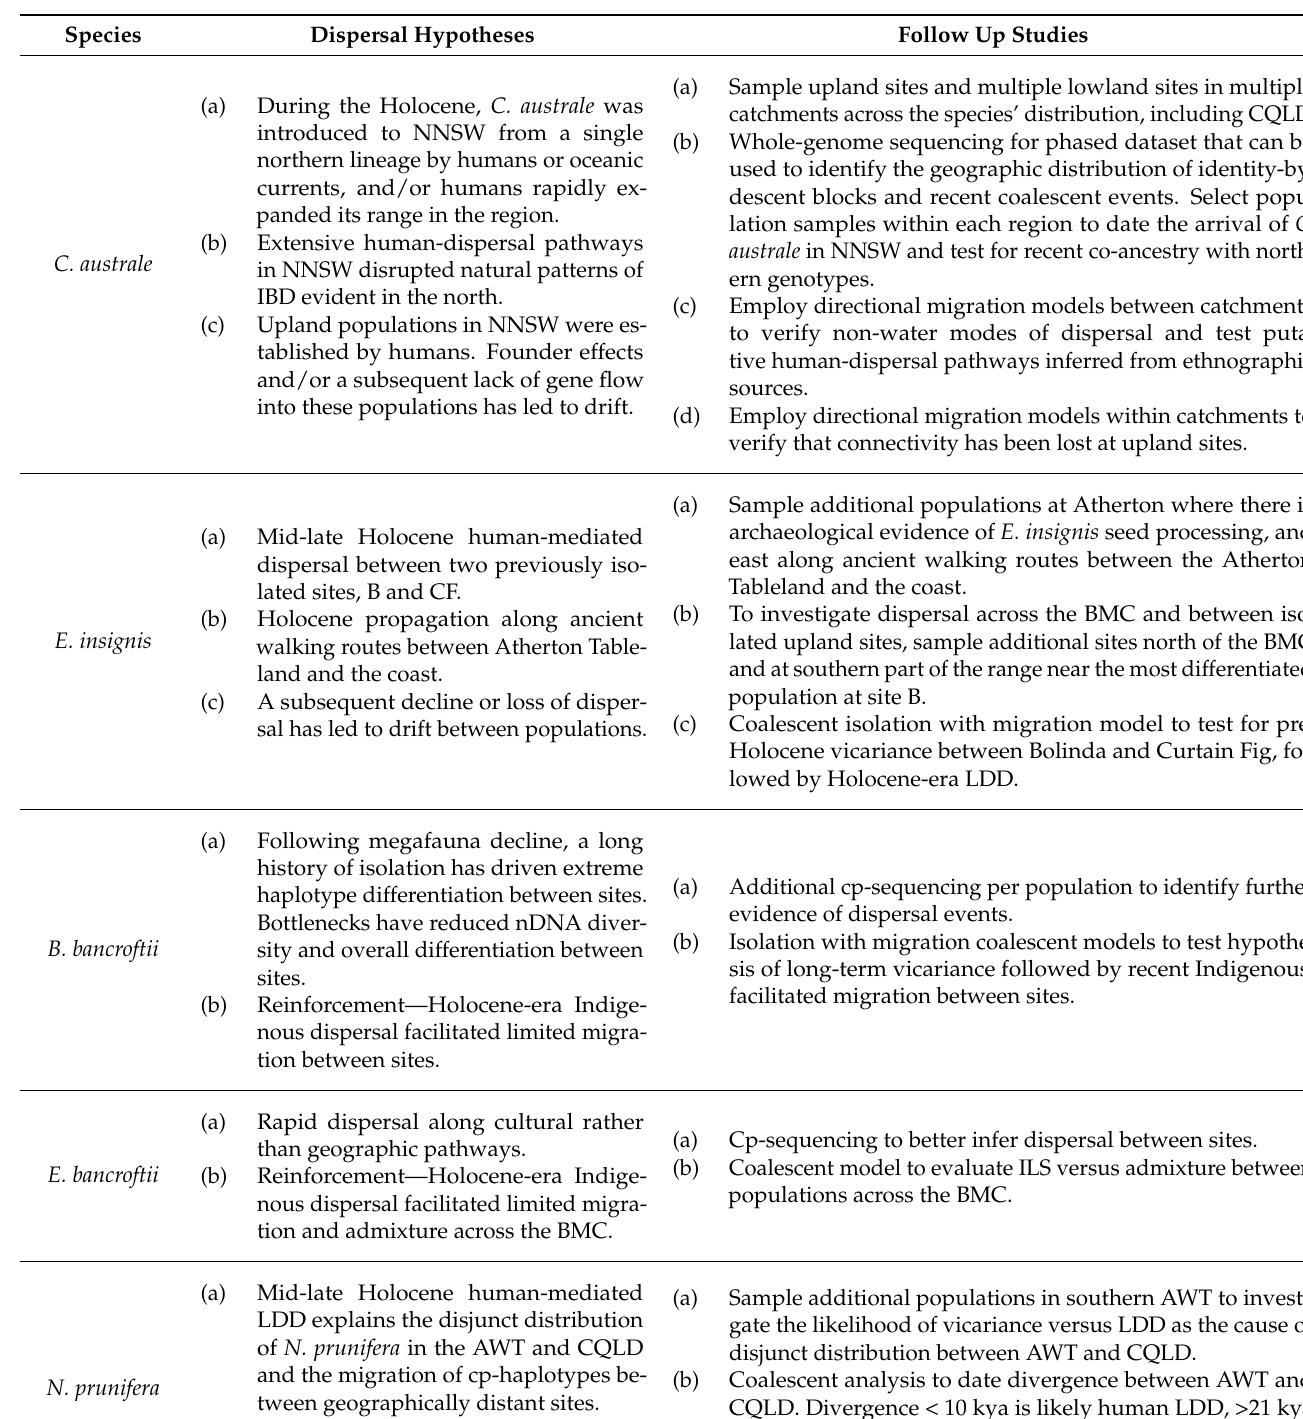
Table 4. Candidate species that warrant investigation of historical Indigenous dispersal and suggested follow up studies. Species were identified as candidates if they displayed at least one of five genomic signals of dispersal that can be tested as anthropogenic vs. non-anthropogenic in future studies, and generated hypotheses on Indigenous dispersal scenarios. We considered species as weak candidates if they displayed genomic patterns from which putative Indigenous dispersal could not be differentiated from widespread faunal dispersal or if they showed an absence of dispersal